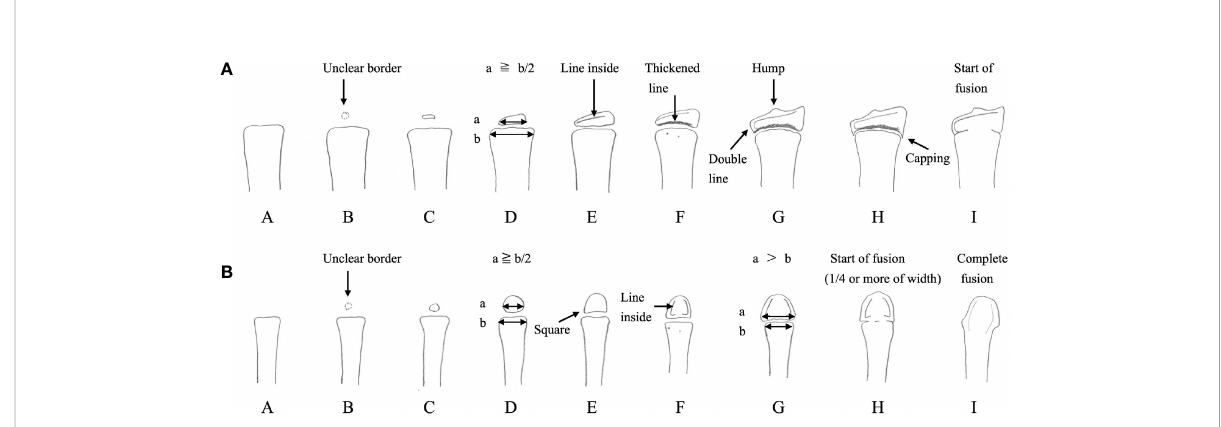
FIGURE 1 Bone maturation process and points of bone age evaluation using the Tanner-Whitehouse 2 method for the radius (A) and the third metacarpal bone (B) The epiphysis gradually enlarges, and its width becomes equal to, or greater than, that of the metaphysis. Afterwards, fusion of the growth plate begins, culminating in the complete fusion of the epiphysis and metaphysis. In the Tanner-Whitehouse 2 method, bone maturation is classi fi ed into stages A – H or I (3). The stage of bone maturation is determined by the size of the epiphysis, its shape and structure, and the degree of growth plate fusion. (Modi fi ed versions of Figure 6-21 and Figure 6-28 from Murata M et al., Assessment of skeletal maturity: A practical manual. Tokyo: HBJ (1997). 65 p. and 68